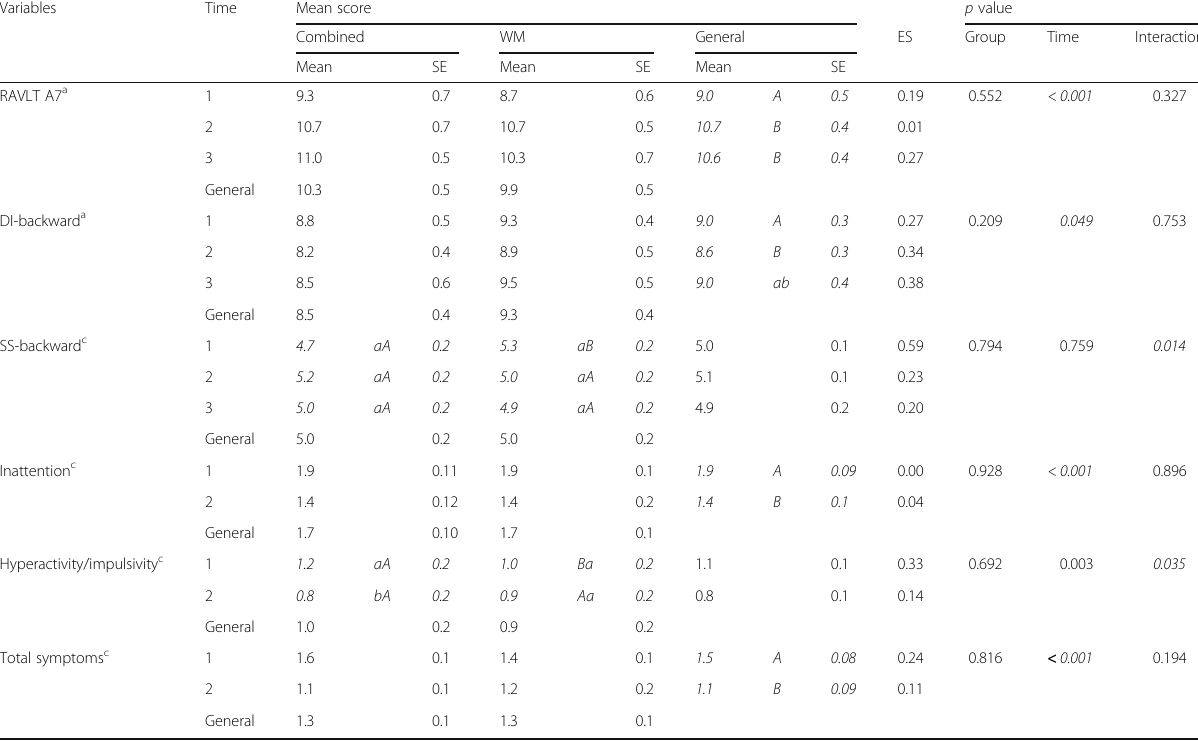
Table 3 Results of GEE and effect size for measures of Working Memory and ADHD symptoms